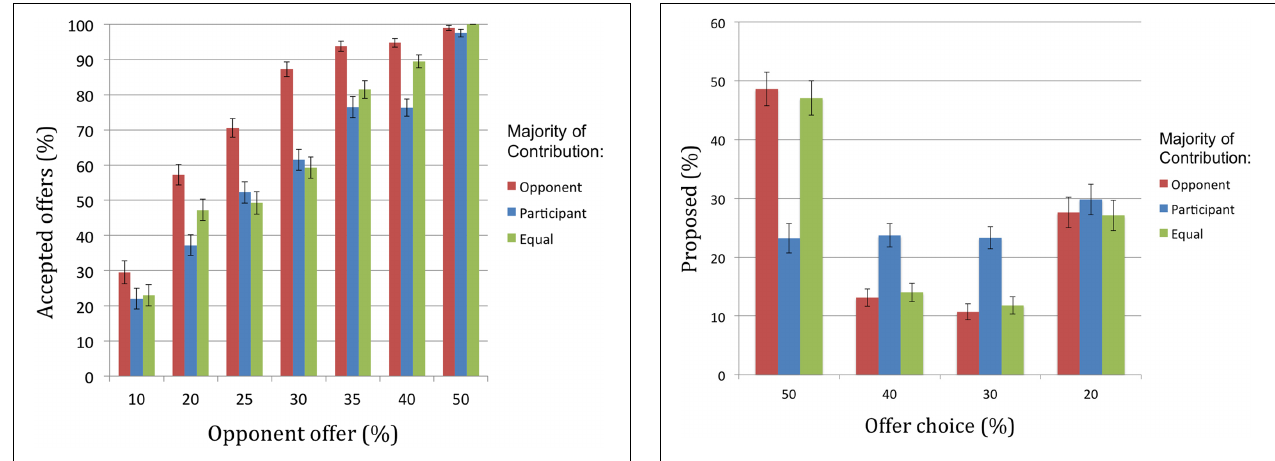
contributing more (mean = 2.06, SD = 2.29), and finally the opponent contributing more (mean = 1.66, SD =